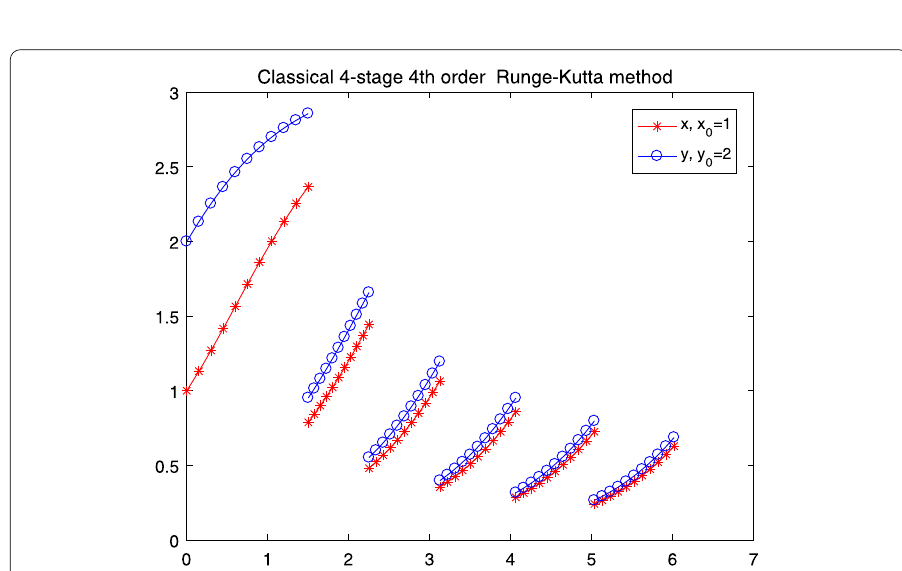
Figure 1 Explicit Euler method for (11)